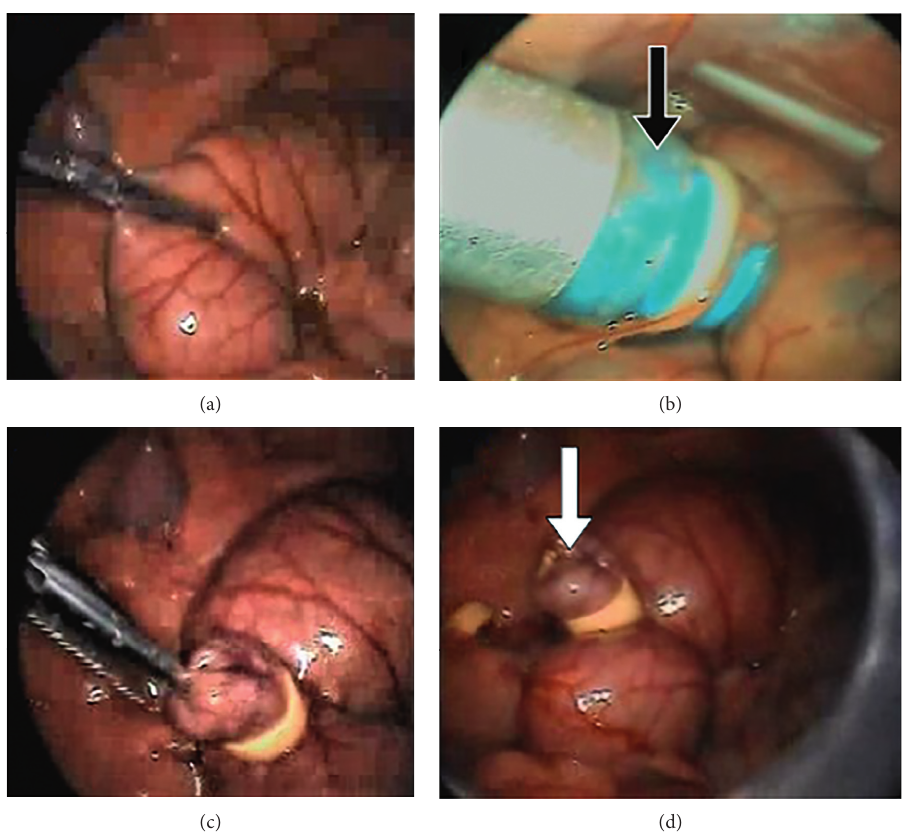
Figure 1: Laparoscopic cecal ligation and puncture showing (a) exposure of cecum; (b) clamping and traction of cecum into the elastic ligature (black arrow); (c) 30% sectioning of the cecal pouch; and (d) releasing of the fecal material into the abdominal cavity (white